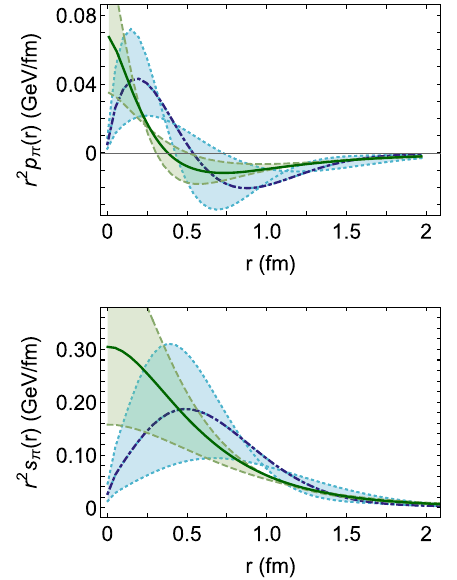
Fig. 4 Upper panel – Pressure distribution in the pion, Eq. (56); and lower panel shear pressure distribution, Eq. (58). Legend. Green solid curve within like-coloured band – computed using the lQCD results for θ ((cid:2) 2 ) in Eq. (55); and blue dot-dashed curve and associated band – 1 computed using θ 1 ((cid:2) 2 ) in Eq. (57)